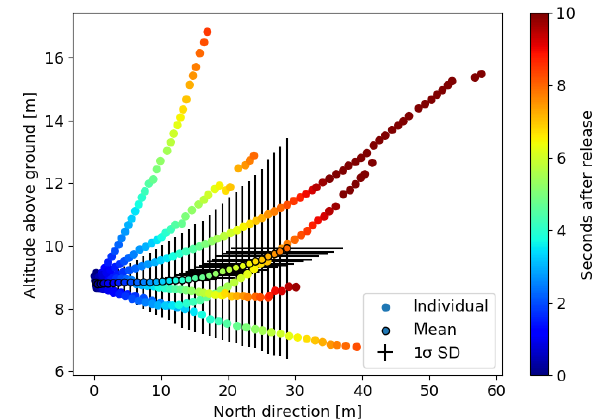
Figure 10. Vertical projections of the CM trajectories to the altitude–north plane. The colour code represents the travel time since release. The mean trajectory and its standard deviation are displayed with black pluses. Note that the x axis scales 6 × larger than the y